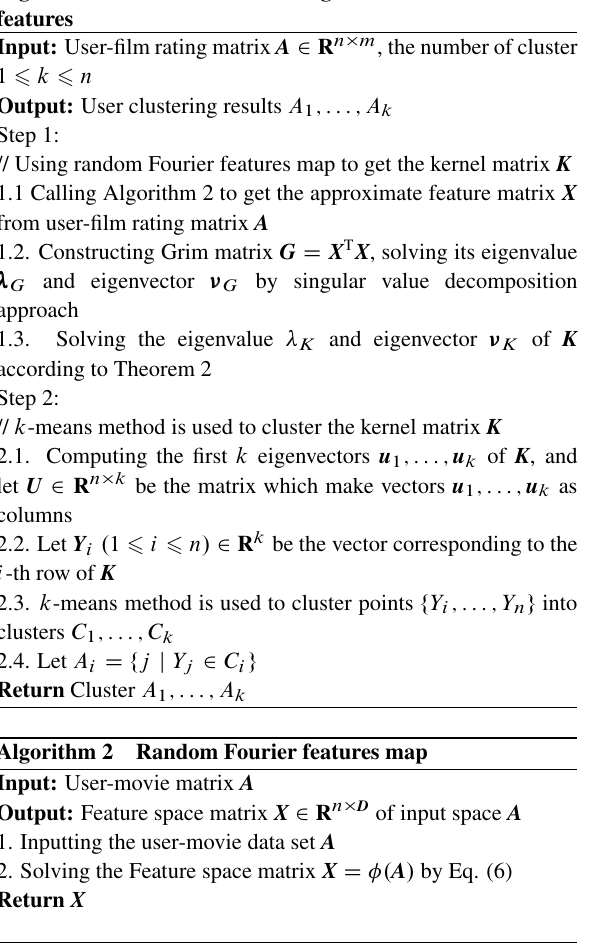
Algorithm 1 Preference clustering based on random Fourier features